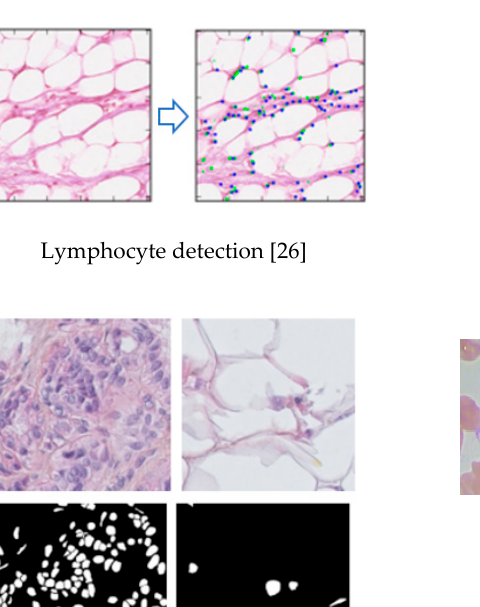
Figure 5. Data-driven traffic forecasting. Using the dynamics of the traffic flow (roads 1, 2, and 3) to capture the spatial dependency using by Diffusion Convolutional Recurrent Neural Network [25].